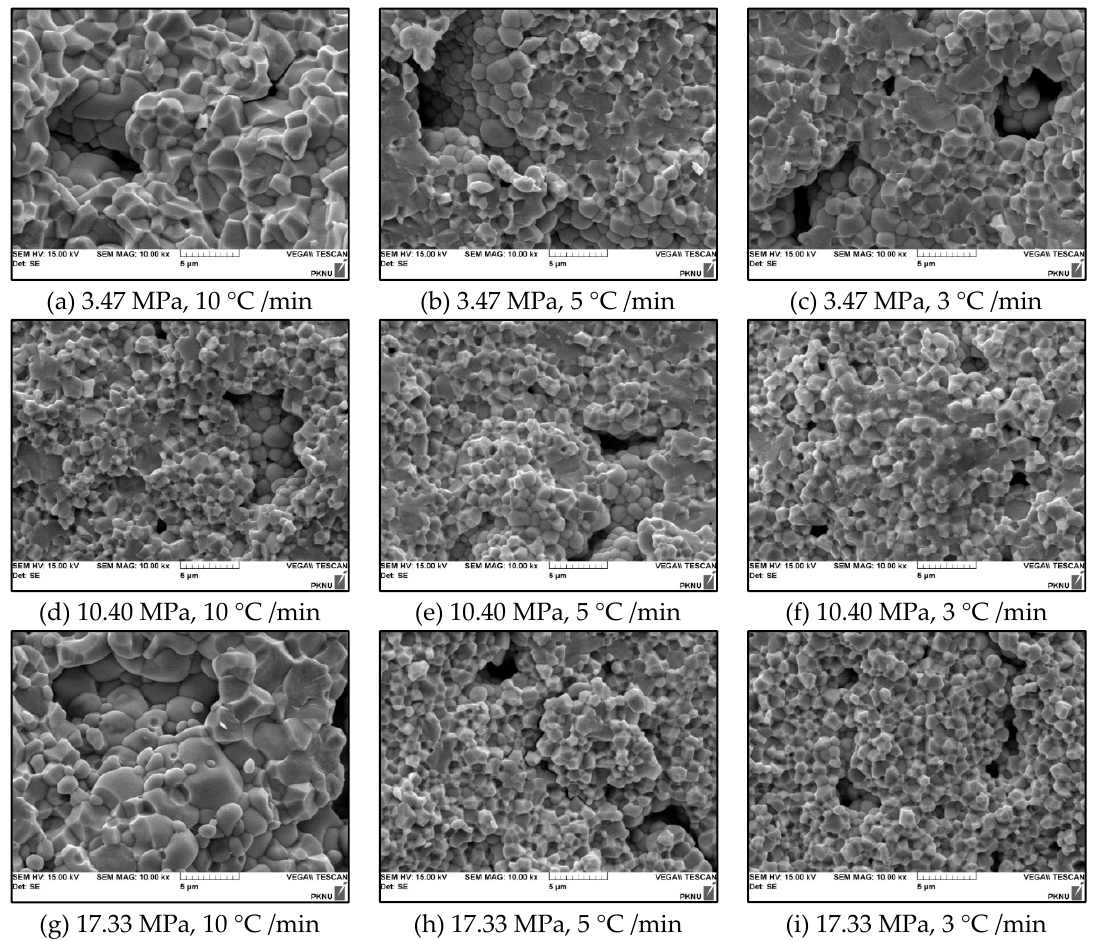
Figure 7. SEM images of fracture surface of the ring-type PZT ceramics according to the forming pressure and the heating rate: ( a ) 3.47 MPa, 10 °C /min ( b ) 3.47 MPa, 5 °C /min ( c ) 3.47 MPa, 3 °C /min, ( d ) 10.40 MPa, 10 °C /min, ( e ) 10.40 MPa, 5 °C/min, ( f ) 10.40 MPa, 3 °C /min, ( g ) 17.33 MPa, 10 °C /min, ( h ) 17.33 MPa, 5 °C /min and ( i ) 17.33 MPa, 3 °C/min.